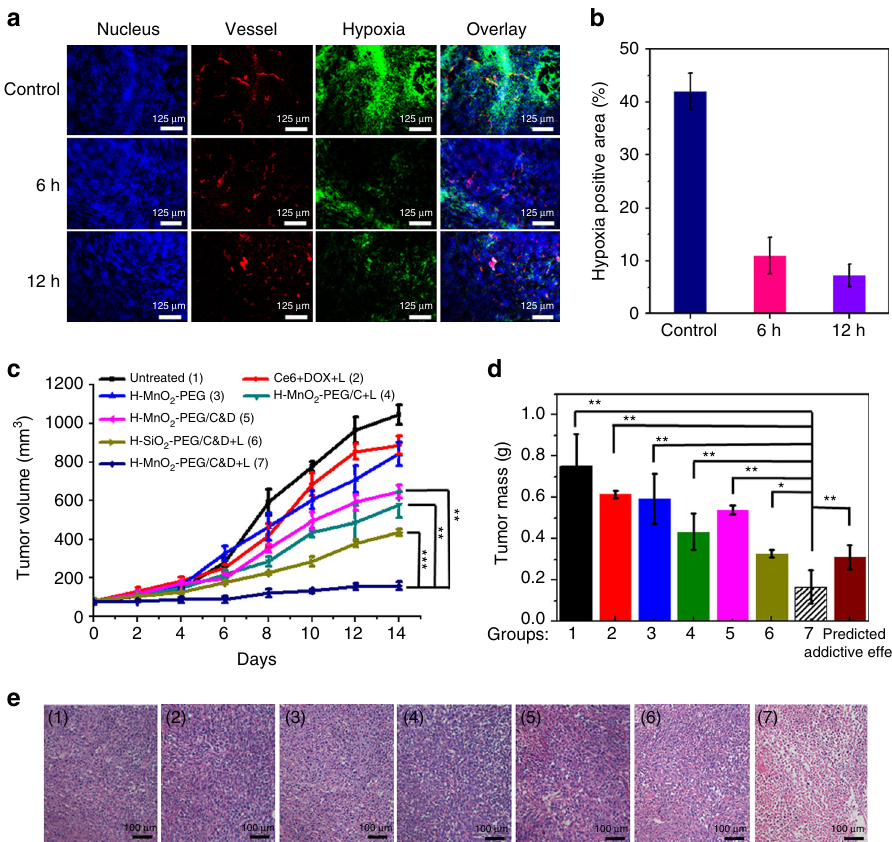
Fig. 5 In vivo combined chemo-PDT treatment with H-MnO 2 -PEG/C&D. a Representative immuno fl uorescence images of 4T1 tumor slices collected from untreated control mice and mice 6 h and 12 h post i.v. injection with H-MnO 2 -PEG/C&D. The nuclei, blood vessels, and hypoxic areas were stained with DAPI (blue), anti-CD31 antibody (red), and anti-pimonidazole antibody (green), respectively (three mice per group). b Quanti fi cation of hypoxia areas in tumors at different time points post injection of our nanoparticles. c Tumor growth curves of different groups of mice after various treatments indicated. Error bars were based on standard errors of the mean (SEM) (six mice per group). d Average weight of tumors collected from mice at day 14th post initiation of various treatments. The predicted addictive effect was calculated by multiplying the tumor growth inhibition ratios of group 4 (PDT alone) and group 5 (chemotherapy alone). e H&E-stained tumor slices collected from mice post various treatments indicated. p values in ( c ) and ( d ) were calculated by Tukey ’ s post-test (*** p < 0.001, ** p < 0.01, or * p <